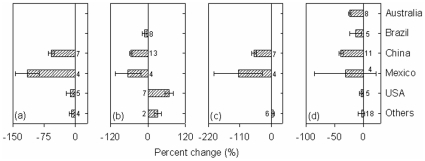
Percent change of ecosystem C pools in aboveground biomass (a) and litter mass (b), belowground biomass (c), and soil C stock (d) from natural forests to plantations in different geographic regions.Values near each bar indicated the number of cases synthesized.